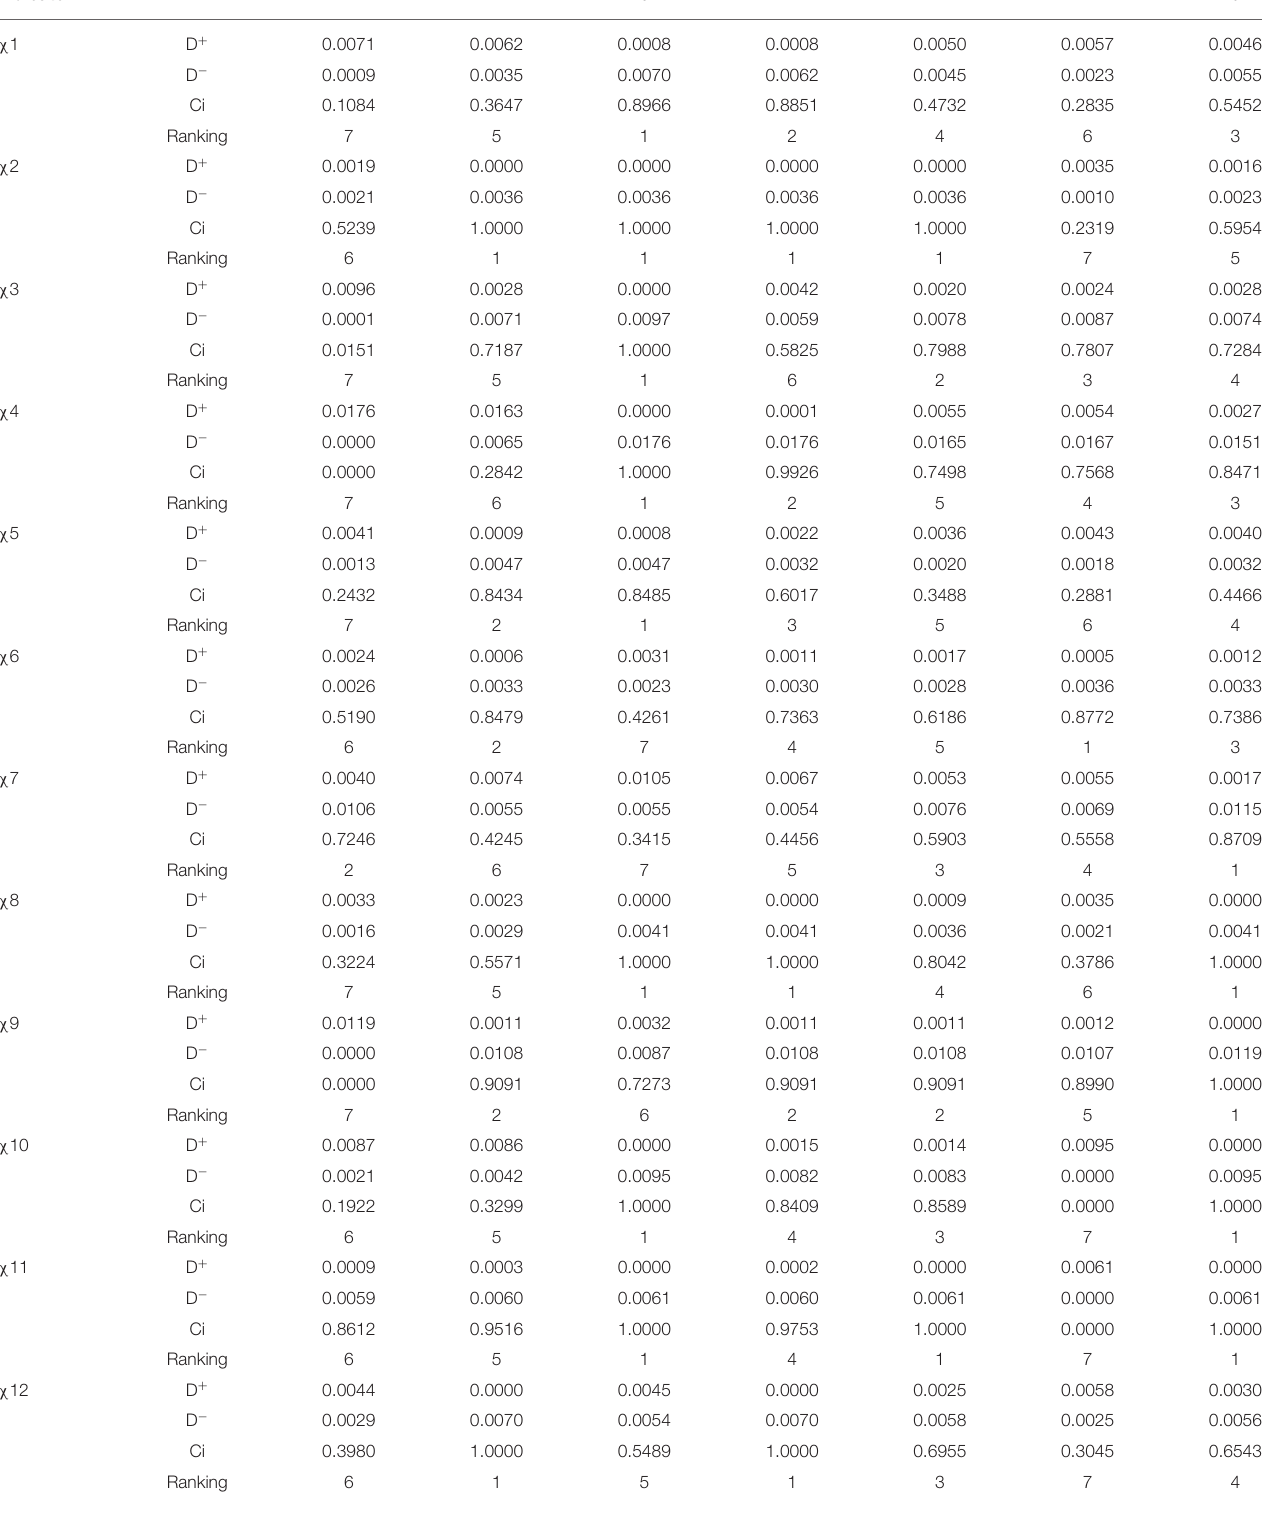
TABLE 4 | Sub-item ranking of the primary indicators for laboratory management.